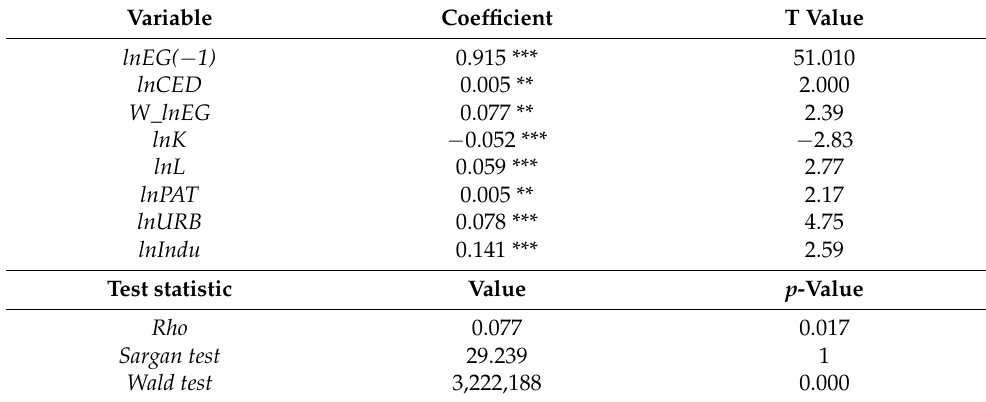
Table 8. The endogeneity test